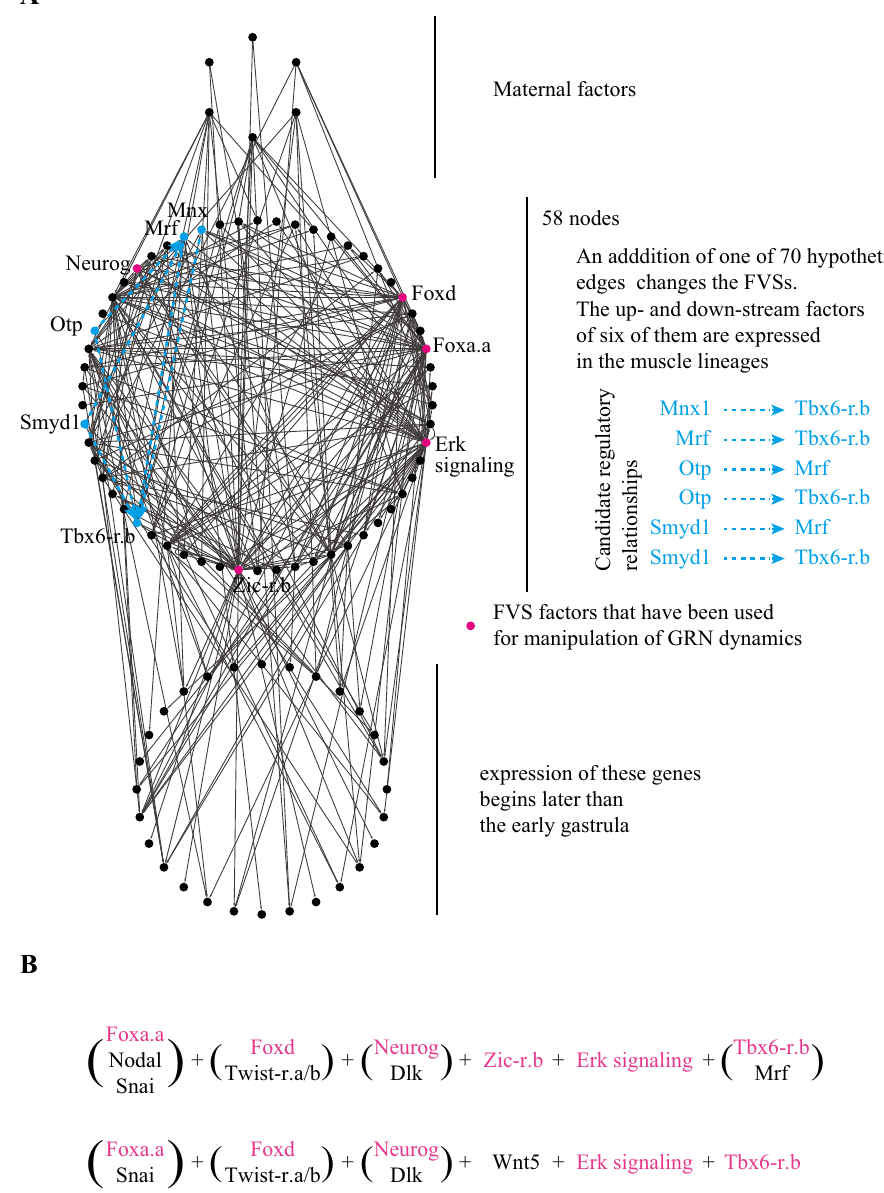
Figure 1. The gene regulatory network for cell fate specification in ascidian embryos. ( A ) The GRN consists of three layers, maternal factors, zygotically expressed factors during fate specification, and genes expressed later. Nodes and edges are represented by dots and arrows. The second layer consists of 58 nodes. An exhaustive search for hypothetical edges that change FVSs identified 70 edges. Among them, edges for which upstream and downstream factors are expressed in muscle cells are shown in cyan. FVS molecules used for manipulation of GRN dynamics are indicated by magenta dots. ( B ) FVSs identified in the updated version of the GRN. Parentheses indicate multiple choices; therefore, there are 32 different FVSs. Factors we used for controlling cell fate are shown in